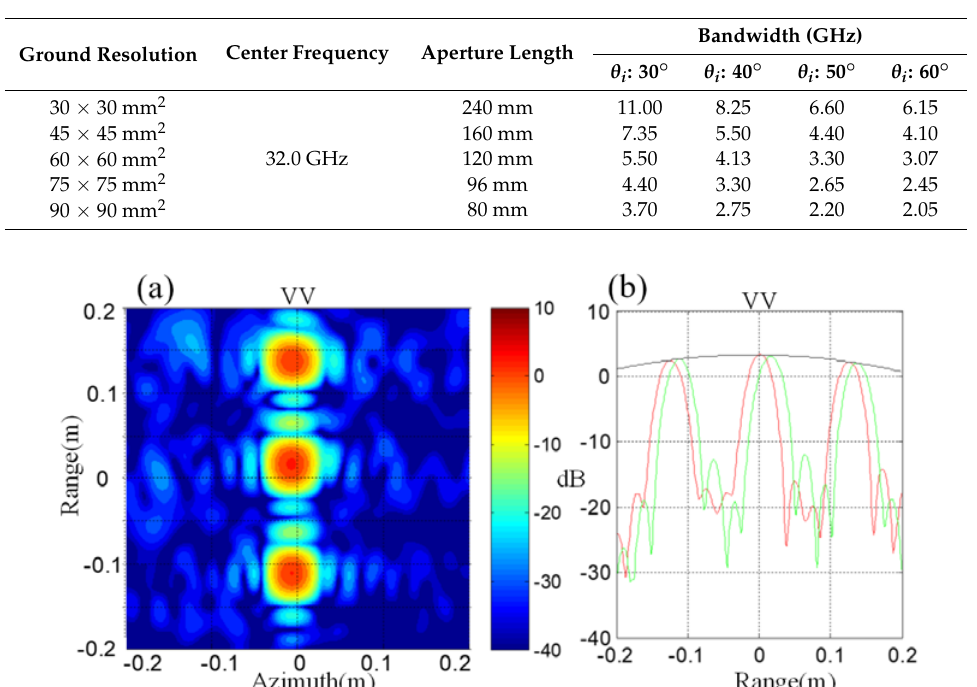
Table 2. Imaging parameters for different resolution cell size ( R = 1.4 m, ground range resolution, Kaiser windows ( β = 2.5) applied in both domains).